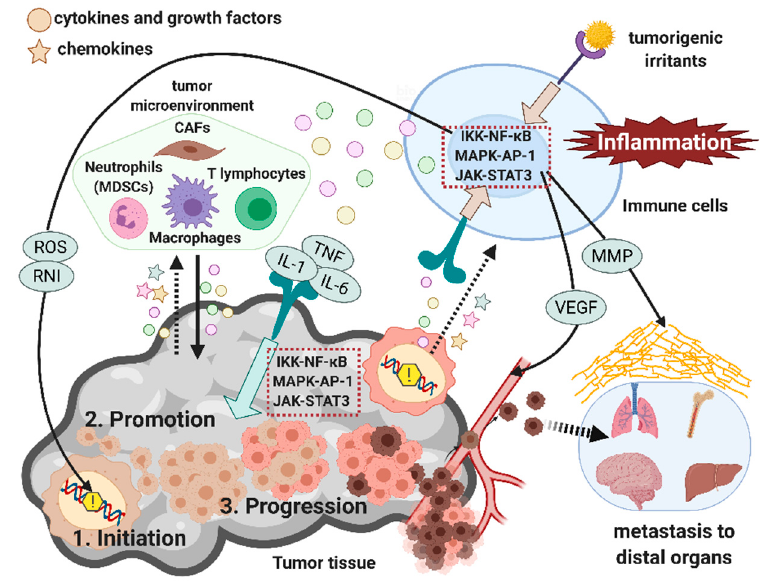
Figure 1. Chronic inflammation promotes tumor progression. Persistent exposure to tumorigenic irritants, such as infected virus and gut microbes, often activates inflammatory signaling, leading to tumor-promoting chronic inflammation. Inflammatory cells often act as a critical source of various tumor-promoting inflammatory mediators, including ROS, cytokines such as TNF, IL-1, and IL-6, and growth factors that directly or indirectly support the entire process of tumor development. Tumor cells also help amplify this inflammatory loop. For example, the dysregulation in cancer-associated genes results in the excessive production of chemokines and cytokines, further recruiting and activating various immune cells (dashed arrows). 4.1. Role of Inflammation in Tumor Initiation Tumor initiation requires accumulation of genetic mutations, epigenetic alterations, or both in cancer-related genes in normal cells. The inflammatory microenvironment largely contributes to this process. Activated inflammatory cells, such as macrophages and neutrophils, are major sources of ROS and reactive nitrogen intermediates (RNIs), which induce DNA damage and genomic instability. Canli et al. demonstrated that myeloid cell-derived ROS triggers genome-wide mutations in epithelial cells and stimulates their malignant transformation [80]. Cytokines released from inflammatory cells also contribute to mutagenesis by elevating intracellular ROS and RNI in premalignant cells. Such inflammation-induced mutagenesis is reported for several important cancer-related genes, such as mismatch repair (MMR) response genes and tumor suppressor TP53 [8]. Chronic inflammation can also induce chromosomal instability and dysregulation of the epigenetic machinery, such as DNA- and histone- modifying enzymes, microRNA, and long non-coding RNA (lncRNA), leading to tumor development. Conversely, inflammation can be triggered by genomic DNA damage. For example, carcinogen-induced genotoxic stress evokes the innate immune DNA-sensing pathway, leading to inflammation-induced skin carcinogenesis [81,82]. Wilson et al. found that the gut bacterial genotoxin colibactin alkylates DNA in vivo , and colibactin-mediated DNA damage might contribute to CRC development [83]. Moreover, chronic inflammation promotes tumor initiation by conferring stem cell- like characteristics on premalignant cells and forming niches that support the survival and maintenance of tumor-initiating cells, thereby expanding targets for mutagenesis [8].